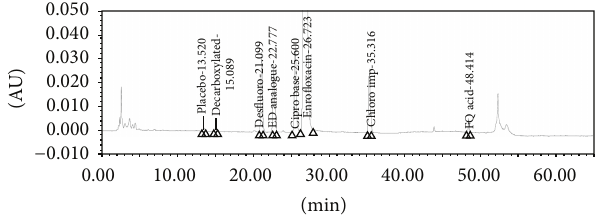
Figure 9: 1% impurities spiked sample at 278 nm.